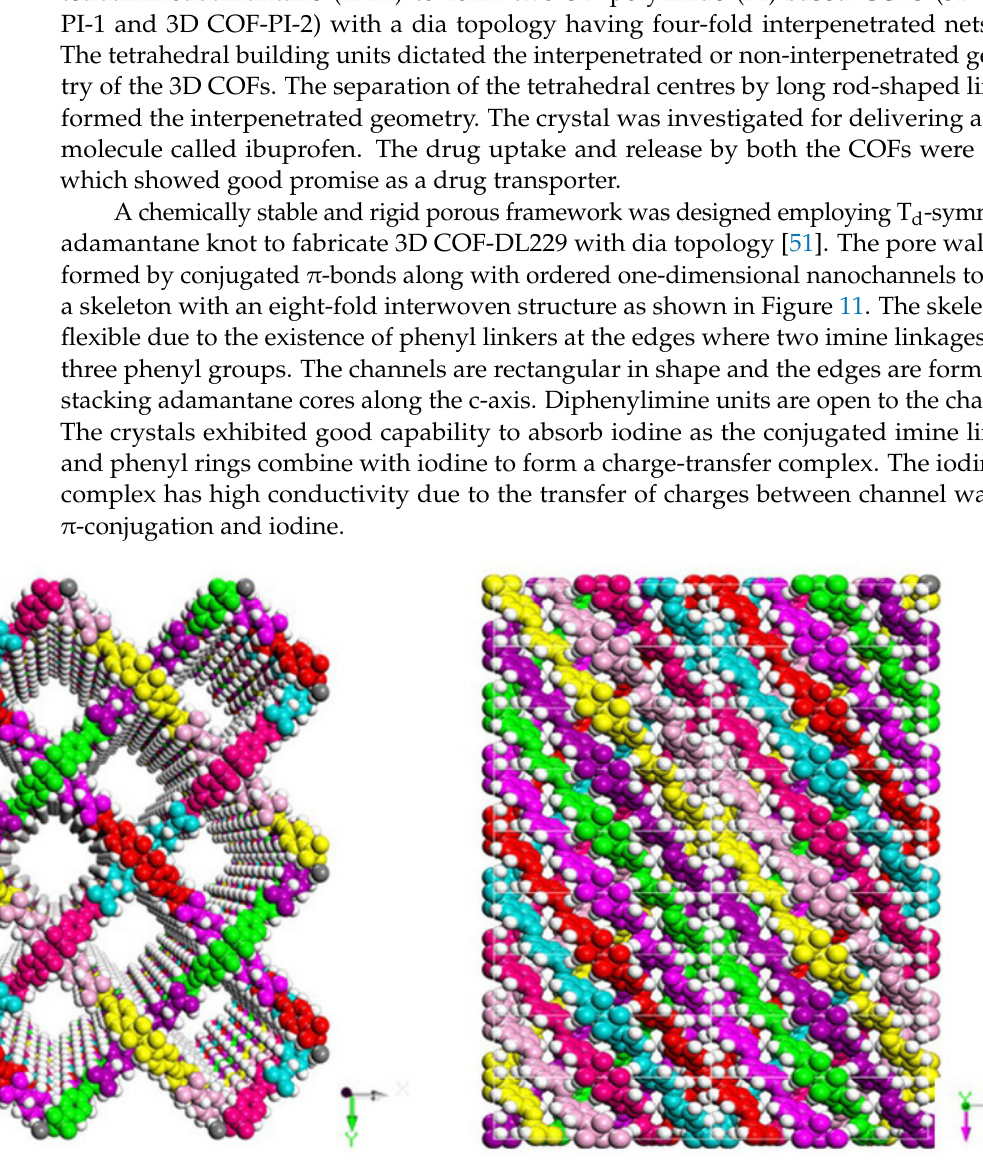
Figure 11. 3D COF-DL229 with dia network [51].